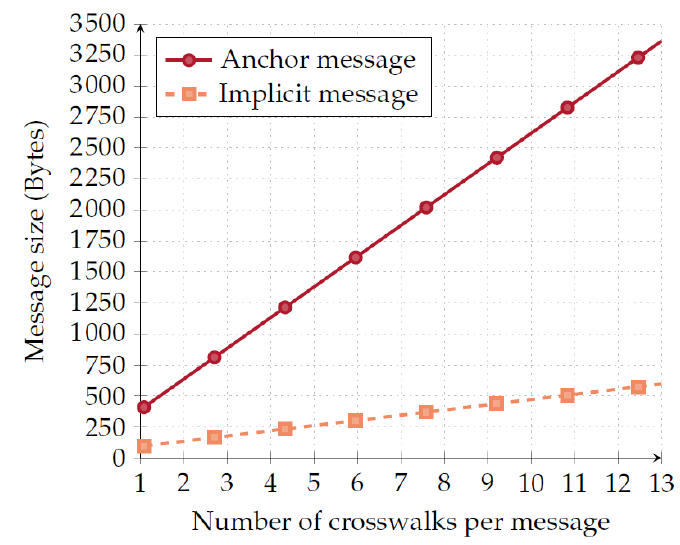
Figure 8. Message size x number of crosswalks.